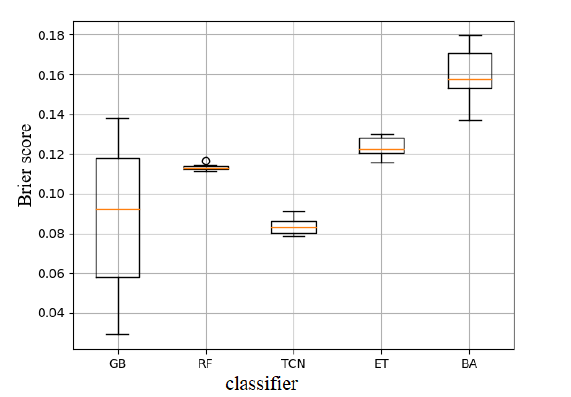
Figure 8. Performances comparisons among five models for time series classification